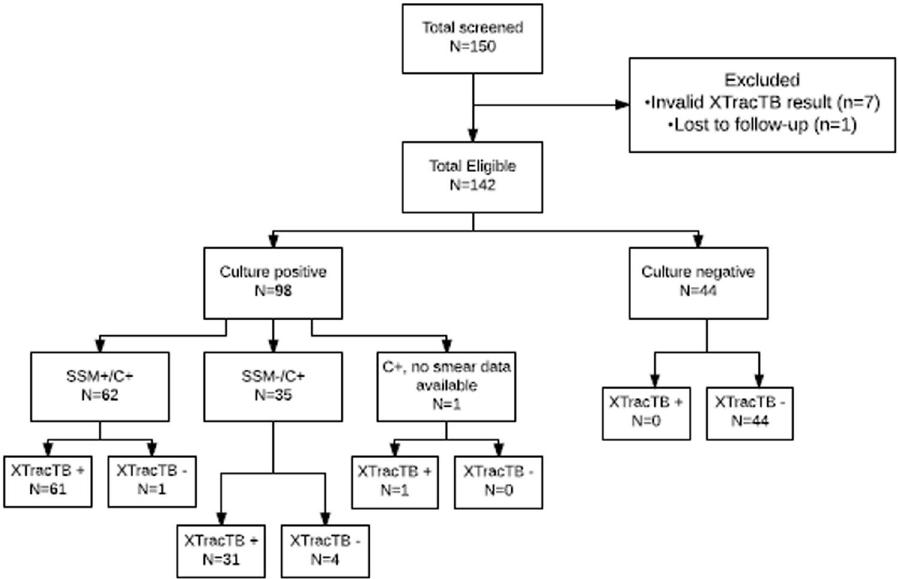
Figure 6. Schematic of study two protocol for sample testing. SSM − = concentrated sputum smear microscopy negative; SSM + = concentrated sputum smear microscopy positive; C + = culture positive.